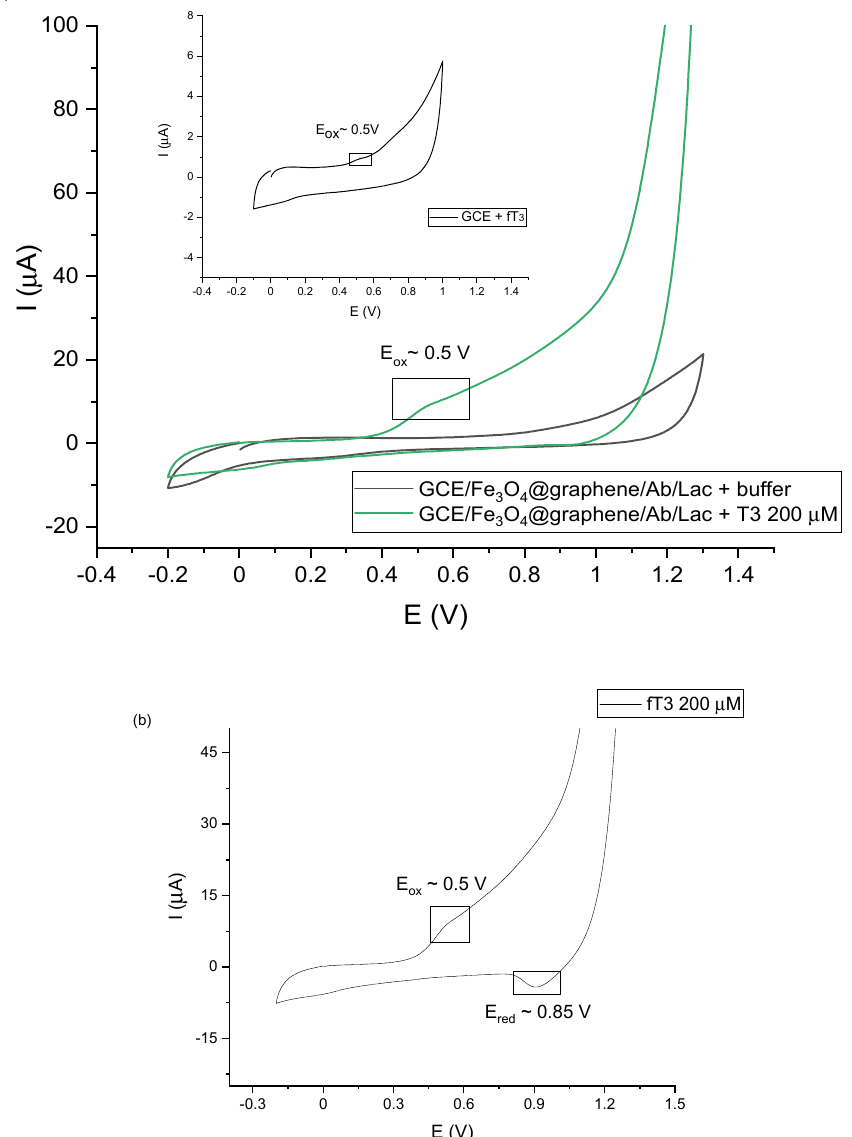
Figure 4. ( a ) Representative CV scans of GCE/Fe 3 O 4 @graphene/Ab/Lac (green line) in the presence of 200 µ M fT3, and GCE/Fe 3 O 4 @graphene/Ab/Lac in PBS buffer (black line); inset: CV scan of a bare GCE in the presence of fT3; ( b ) GCE/Fe 3 O 4 @graphene/Ab/Lac in 200 µ M fT3; all measurements were performed under applied potential in the range of − 0.2–1.3 V, scan rate 50 mV s − 1 , vs.